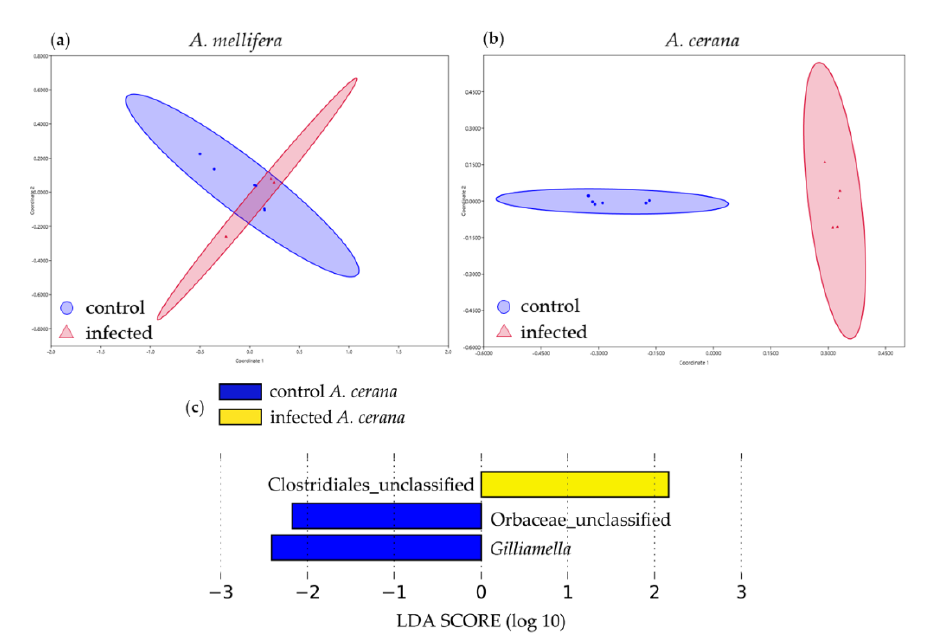
Figure 4. The non-metric multidimensional scaling (NMDS) analysis of larval bacterial communities in A. mellifera ( a ) and A. cerana ( b ) with linear discriminant analysis (LDA) score of bacteria that was a ff ected by SBV infection ( c ) .